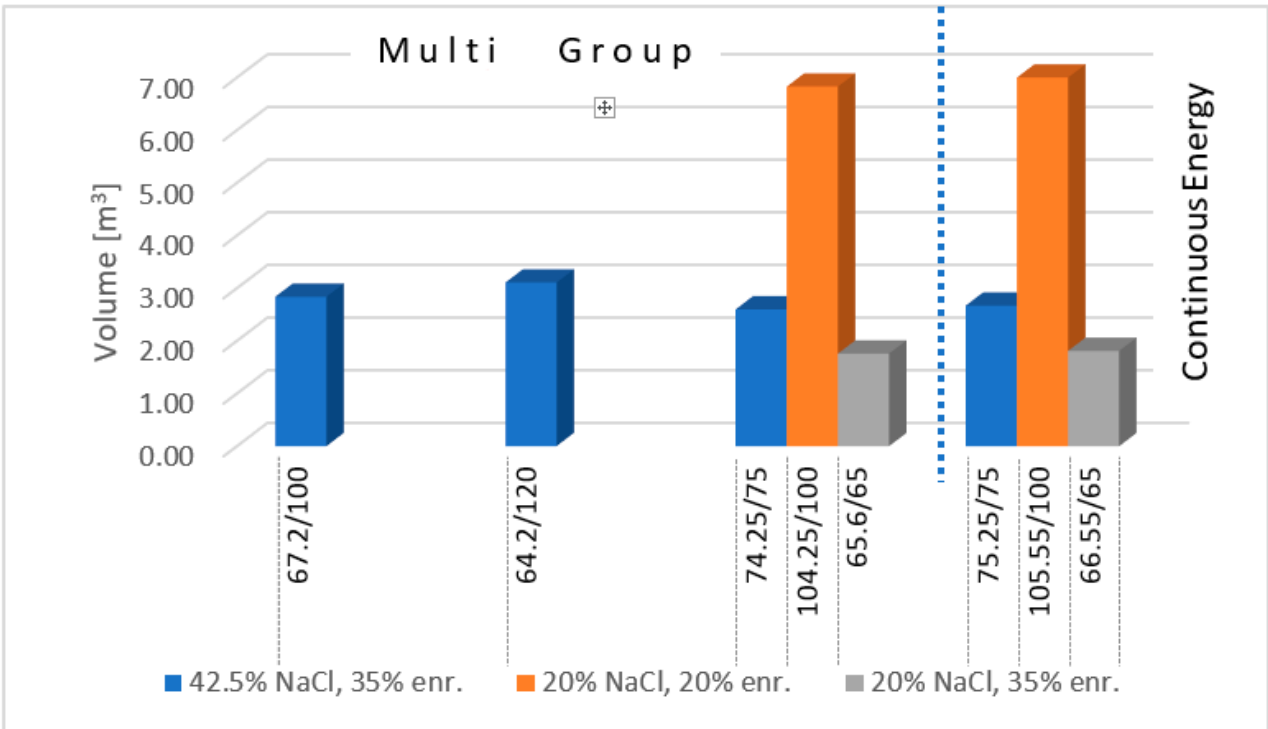
Figure 14. Expected core volumes for the different studied cases using multi-group and continuous energy Monte-Carlo simulations.